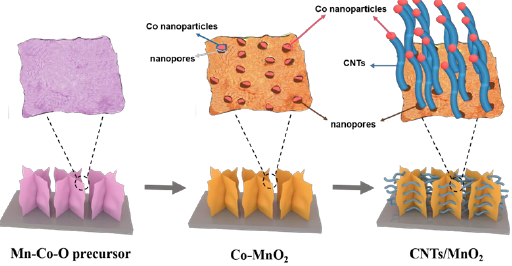
Figure 4: Through a hydrothermal process, Mn-Co-O precursor nanosheets have been vertically grown on Ni foam. Then, the pre- cursors firstly transfer to metal Co embedded MnO 2